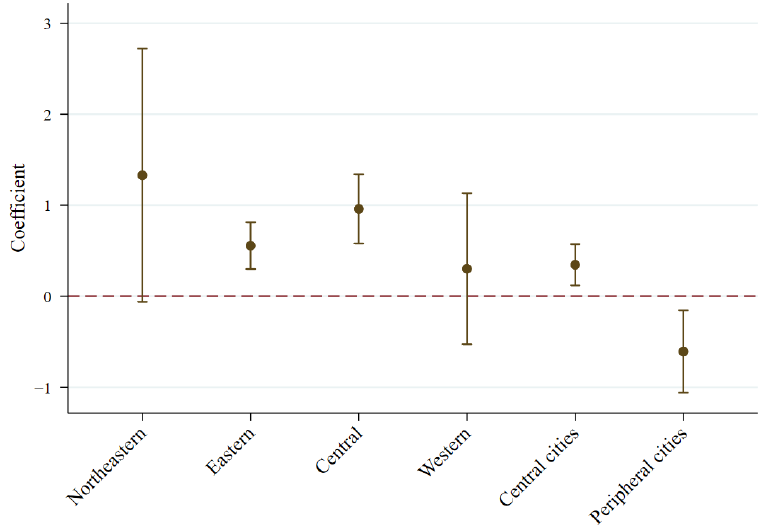
Figure 4. Regression results based on heterogeneity of sub-regional and